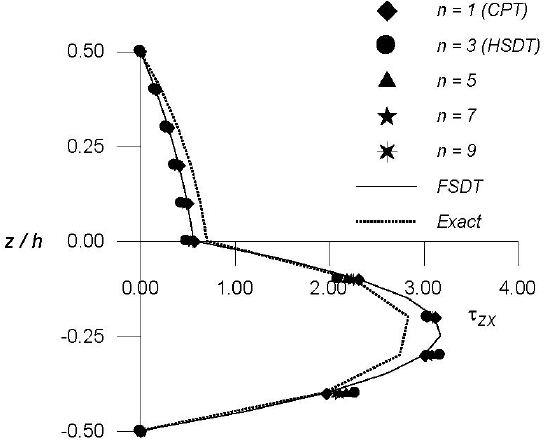
Figure 5: Through thickness distribution of bending stress ( ¯ σ x ) for simply supported two layered (0 ∘ /90 ∘ ) un-symmetrically laminated composite plates with a / h = 4 and E 1 / E 2 = 25